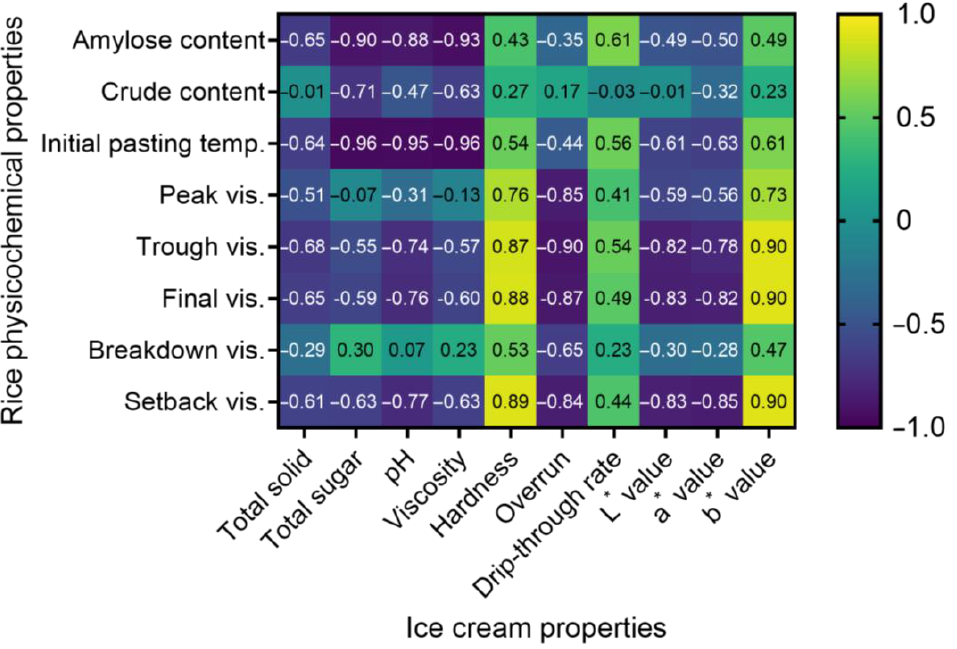
Figure 4. Correlation coefficients heat map between physicochemical properties of ice cream and characteristics of processed rice. Yellow indicates a positive association, and blue indicates a negative association.